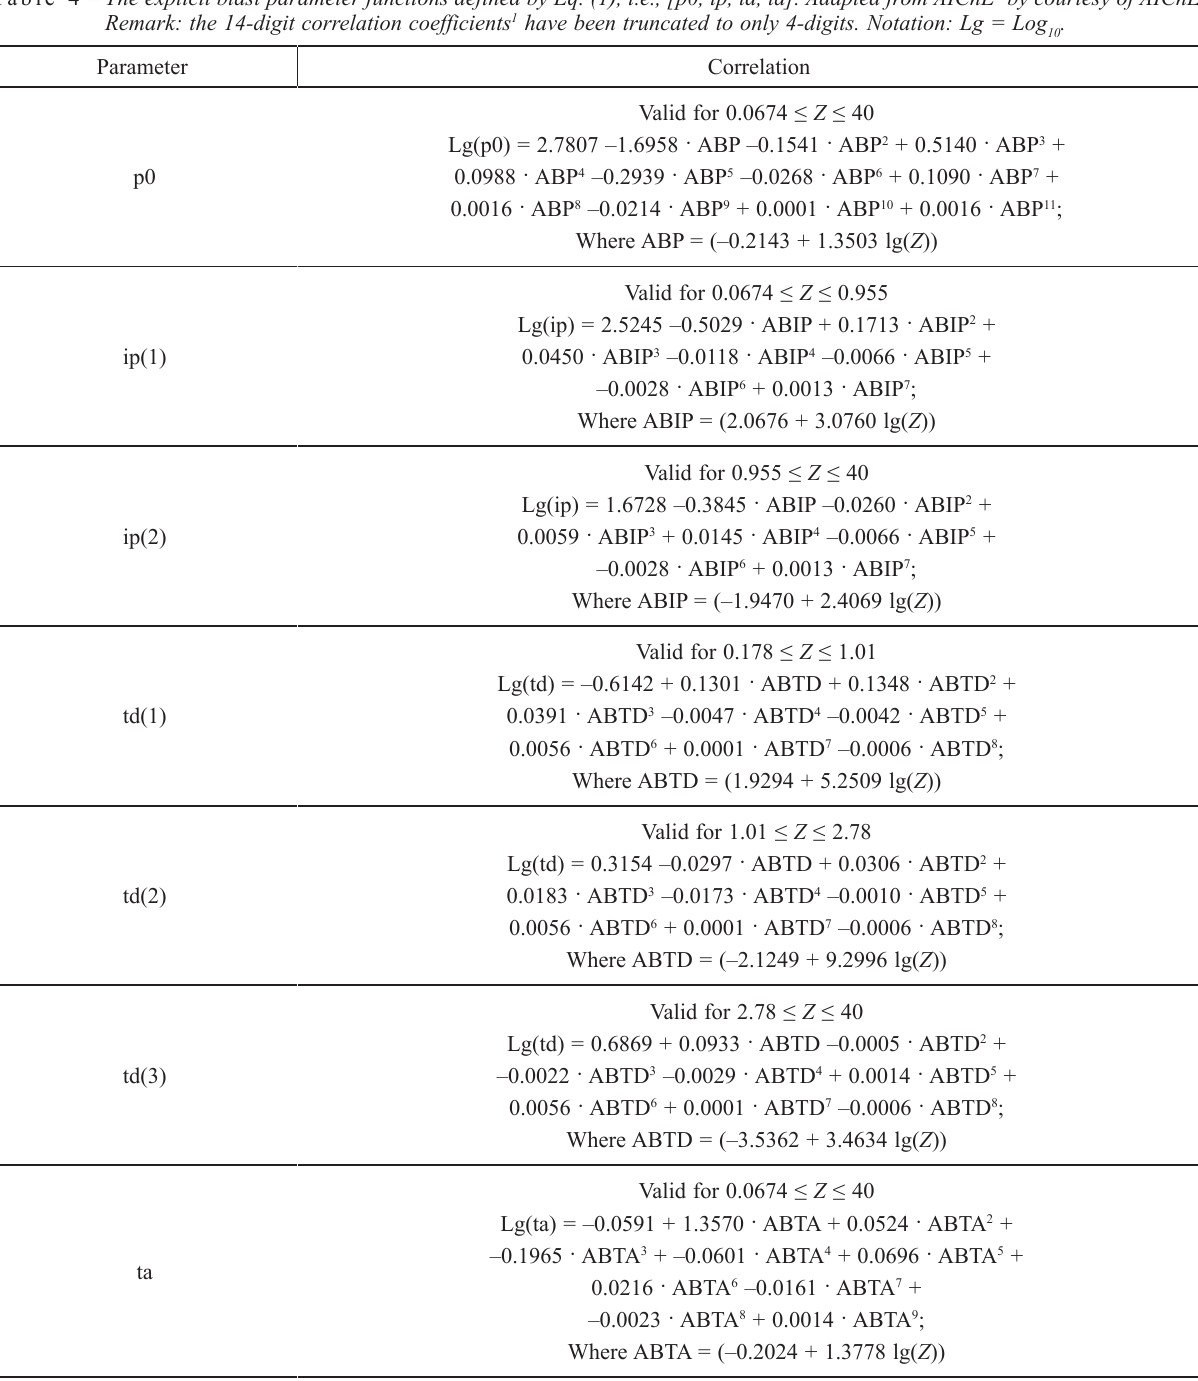
Table 4 – The explicit blast parameter functions defined by Eq. (1), i.e., [p0, ip, td, ta]. Adapted from AIChE 1 by courtesy of AIChE. Remark: the 14-digit correlation coefficients 1 have been truncated to only 4-digits. Notation: Lg = Log